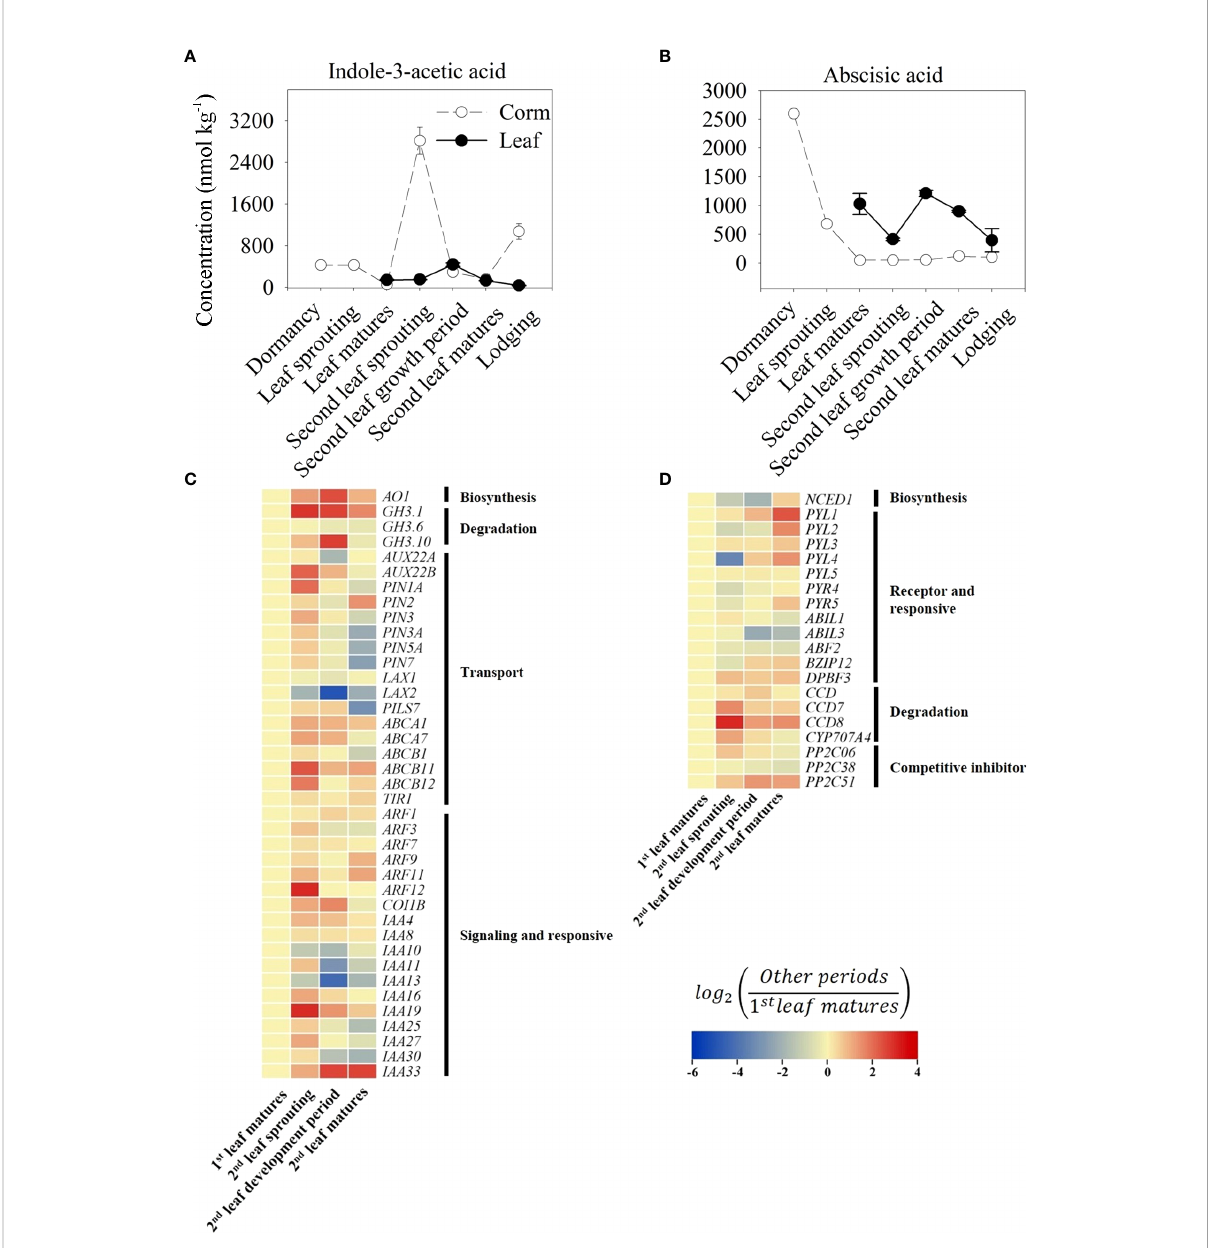
FIGURE 5 Trends of indole-3-acetic acid (IAA, A ) and abscisic acid (ABA, B ) content in growth cycle of A. muelleri . Error bars represent the SE (n=3), and different letters indicate signi fi cant differences compared with different growth periods (P<0.05, based on ANOVA, followed by Tukey ’ s post-hoc tests for comparison). Expression pro fi le of transcripts involved in the IAA (C) and ABA (D) signaling pathways. Changes in transcript levels are indicated by color codes. Red shows upregulated, and blue indicates downregulated of gene expression (using FPKM values) compared with fi rst leaf matures period. Two color log scales are